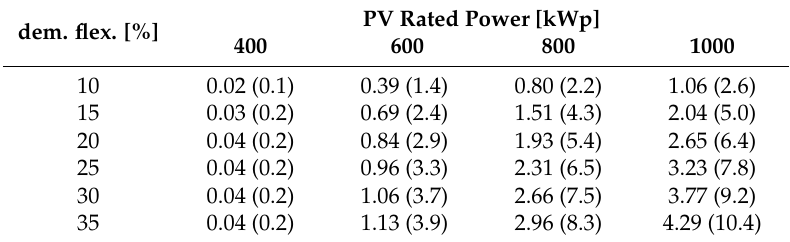
Table 4. A summary of achievable additive savings (expressed in percent of baseline operational costs) over the baseline savings achieved using only renewable generation and ratio of these additional savings when compared with baseline savings with the same PV power (in percentage, given in in parentheses) with realistic demand flexibility levels and supposed high renewable penetration.